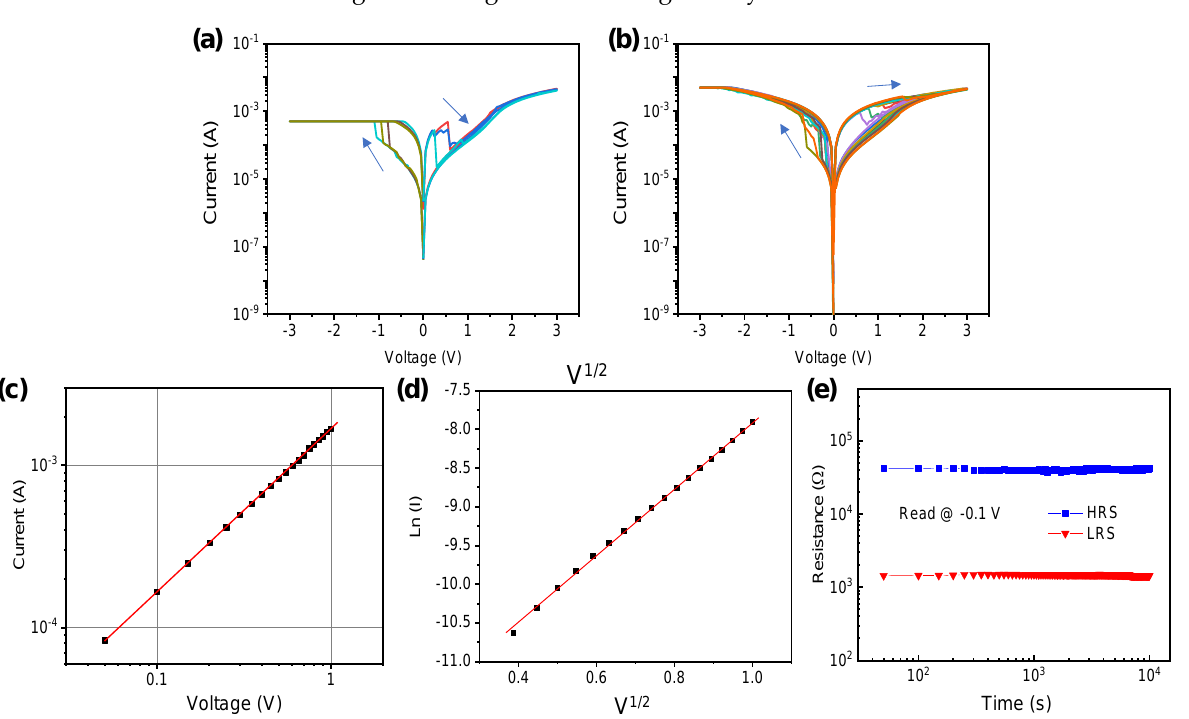
Figure 3. I–V curve of TiN/TaO x /ITO devices when set and reset processes at a negative bias and a positive bias, respectively. ( a ) Low current switching operation with CC and ( b ) high current switching with self-compliance. ( c ) Log–log scale in LRS and ( d ) ln( I ) versus sqrt ( V ) fitting plot in the HRS. ( e ) Retention time of LRS and HRS.